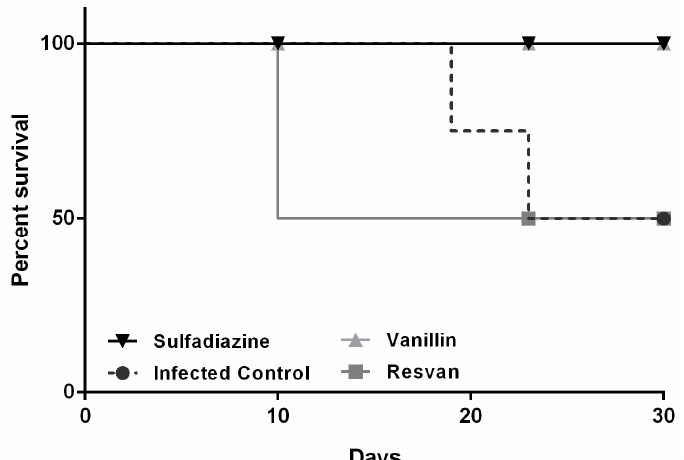
Figure 6. Survival curves of Swiss female mice after infection with the ME49 strain of T. gondii and treated with sulfadiazine (200 mg/Kg), resvan (500 mg/Kg) or vanillin (500 mg/Kg).